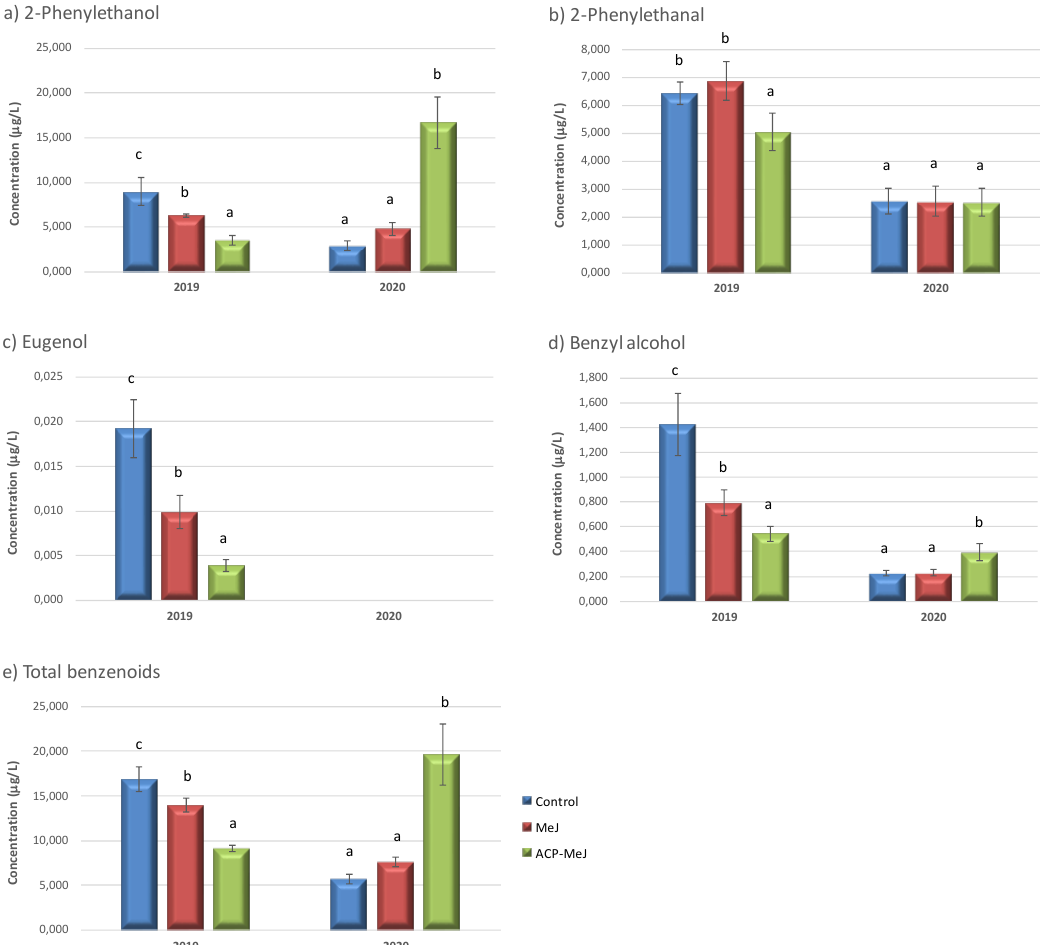
Figure 3. Benzenoid compounds concentration (µg/L) in grapes from control, methyl jasmonate (MeJ) and nanoparticles doped with MeJ (ACP-MeJ) foliar treatments, in 2019 and 2020 seasons. All parameters listed with their standard deviation ( n = 3). For each season and compound, different letters indicate significant differences between samples ( p ≤ 0.05).